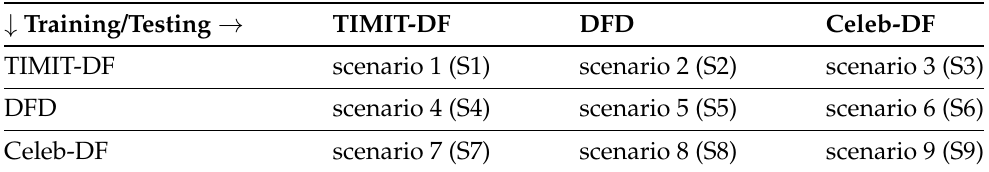
Table 6. Representation of the considered training and testing scenarios, given by differentiation of the training and testing datasets